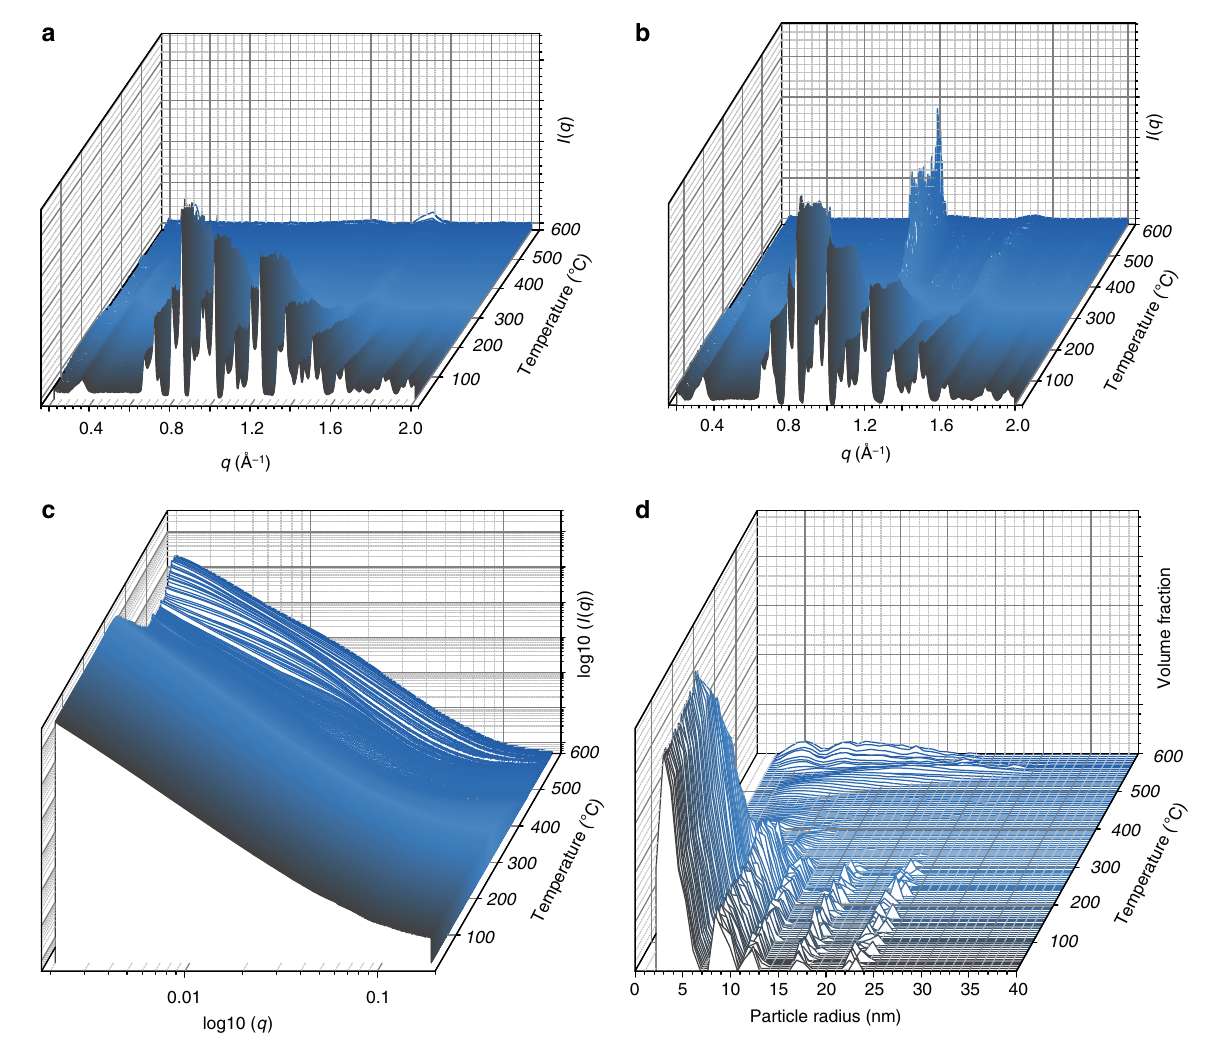
Fig. 2 Temperature-resolved diffraction. a Temperature-resolved WAXS pro fi le of ZIF-62 upon heating from 25 °C to 600 °C. b The corresponding data for (ZIF-4-Co)(ZIF-62)(50/50). c Temperature-resolved SAXS pro fi le for (ZIF-4-Co)(ZIF-62)(50/50). d Temperature-resolved volume fraction distributions of